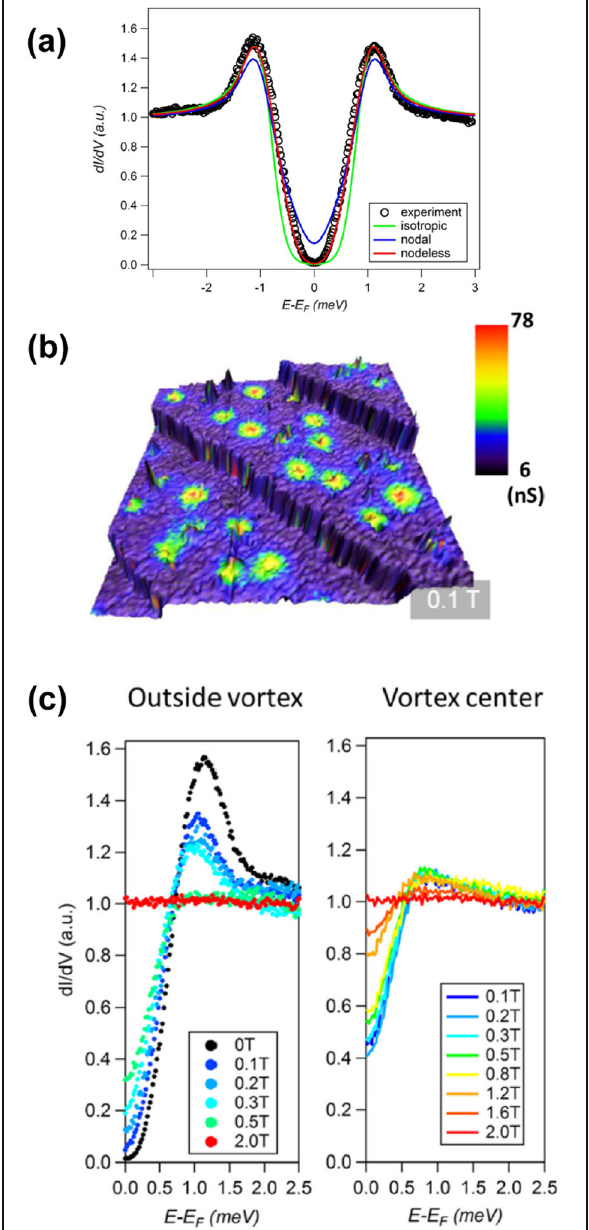
Fig. 7 STM measurements taken for Si(111)-( √ 3 × √ 3)-TlPb. a dI/dV spectra taken at T < 0.5 K and fitting results with three kinds of gap functions (isotropic, nodal, and nodeless gap functions). b The zero bias dI/dV mappings (color code) superimposed on the topographic images (height) obtained at B = 0.1 T (scan area 1 μ m × 1 μ m). c The dI/dV spectra acquired outside vortices (left) and at the vortex center (right) under different magnetic fields. Reprinted figure with permission from T . Nakamura et al. Phys. Rev. B 98 , 134505